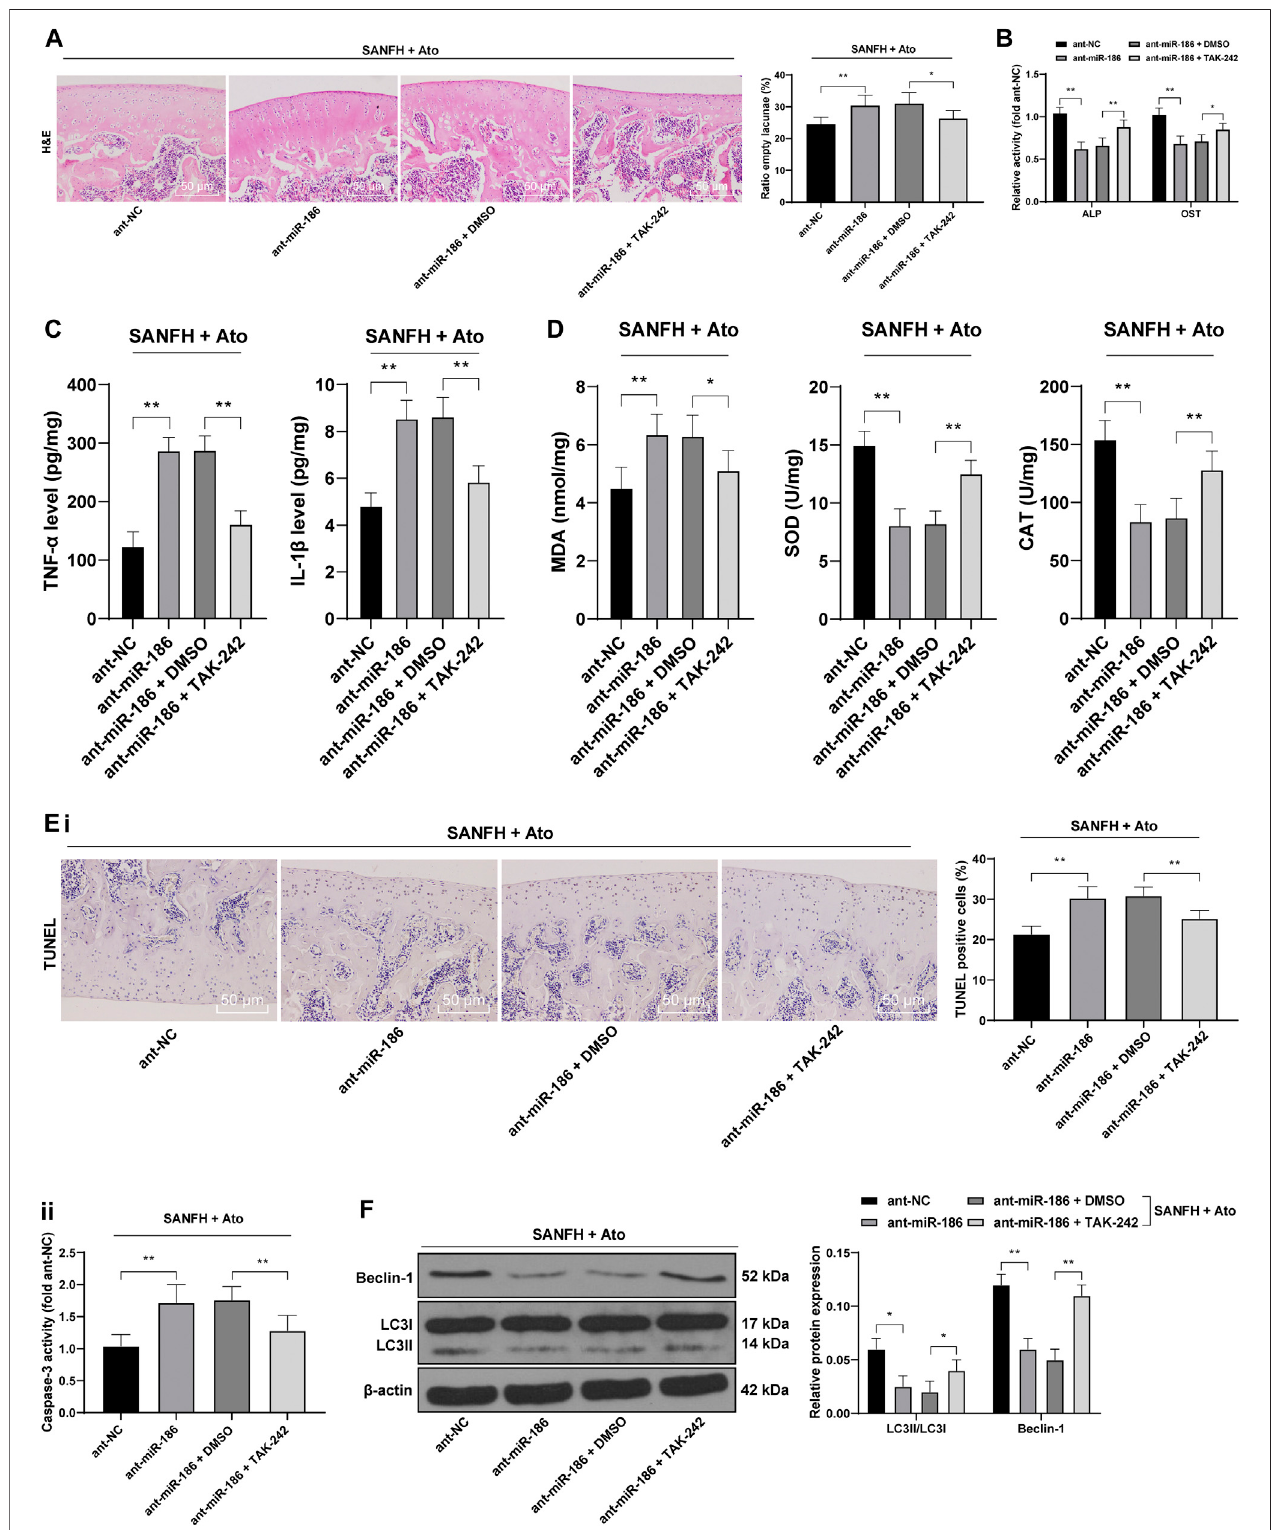
FIGURE3| miR-186inhibitsTLR4toalleviateSANFH-inducedinjuryafterAtotreatment.AfterAtotreatment,SANFHratswereinjectedwithmiR-186antagomiror TAK242. (A) HE staining was used to observe the structure of the femoral head and the rate of empty lacunae; (B) ELISA measured the activity of ALP and OST in the femoralhead; (C) ELISAmeasured TNF- α and IL-1 β levelsinthefemoralhead; (D) ELISAmeasured MDA, SOD,and CAT levelsinthefemoralhead; (E) apoptosisofthe femoral head was detected by TUNEL assay (i) and caspase-3 activity test (ii) ; (F) Western blot analysis was used to detect LC3II/LC3I and the expression of Beclin-1 to evaluate the autophagy of rat femoral head. n (cid:1) 6 in each group. The data are shown in mean ± standard deviation. * p < 0.05, ** p < 0.01. Frontiers in Pharmacology |